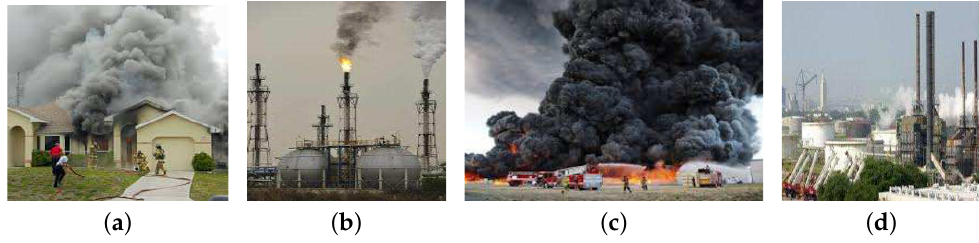
Figure 1. ( a – d ) show the fire and smoke image data sets with none-smoke